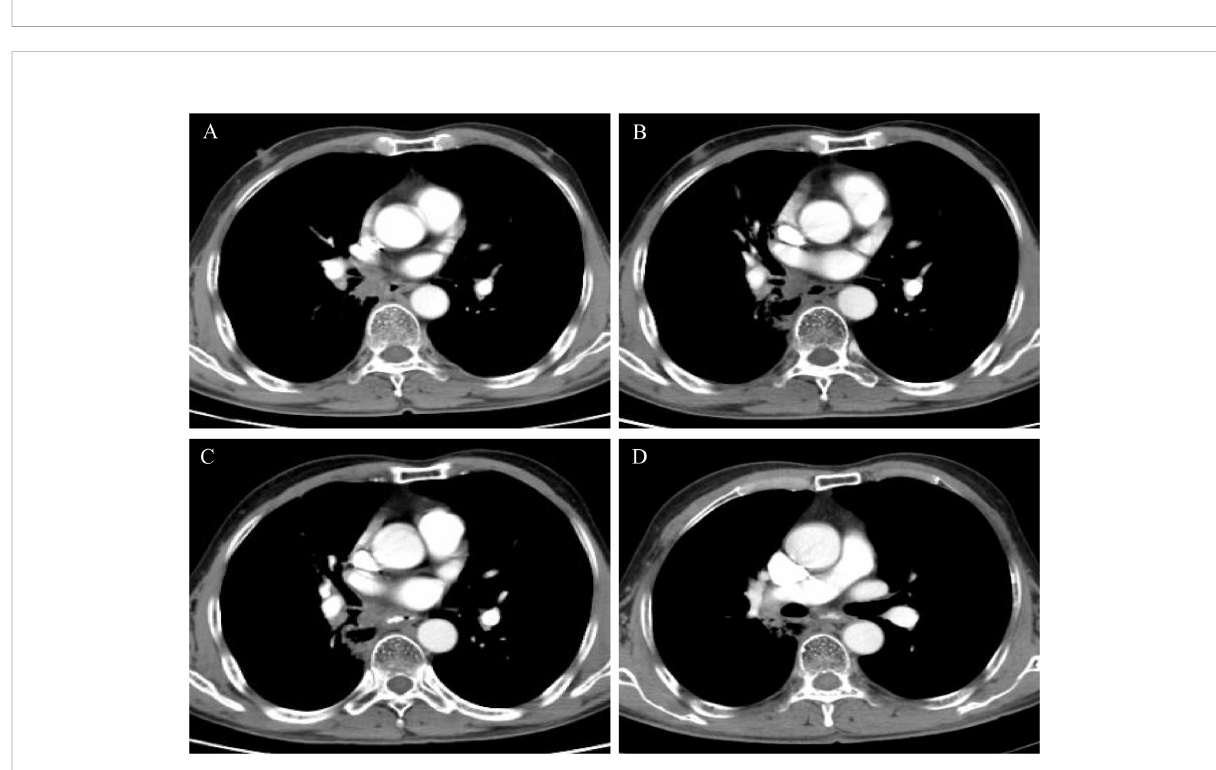
FIGURE 2 (A) Computed tomography (CT) scan after chemoradiation showed partial response; (B – D) CT scan showed stable disease during osimertinib